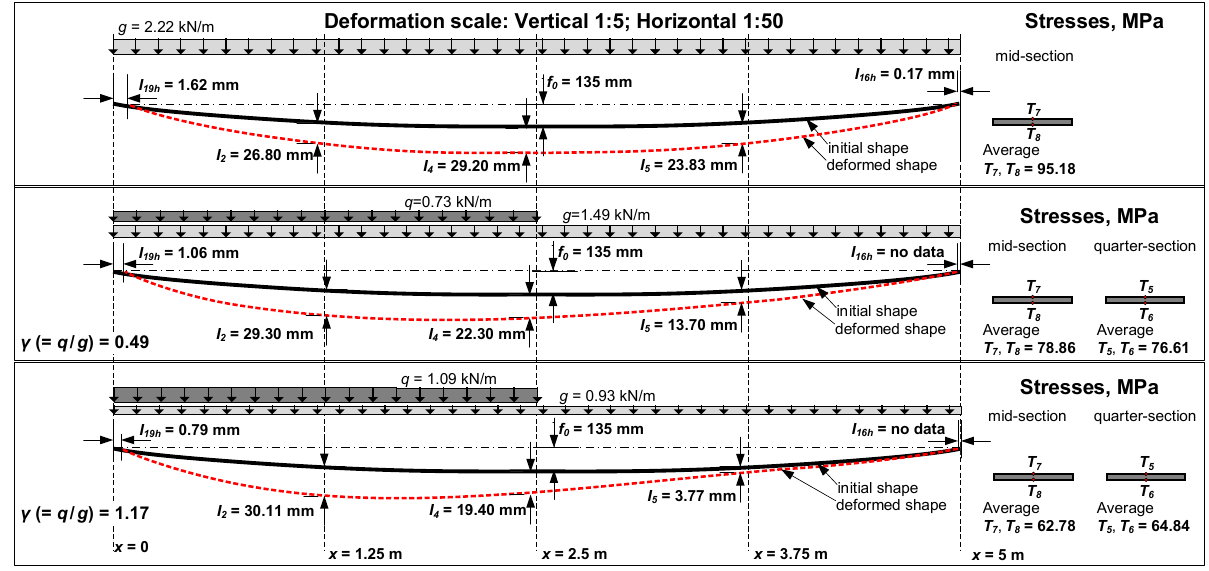
Figure 6. Monitoring results of the bridge Model-1 .